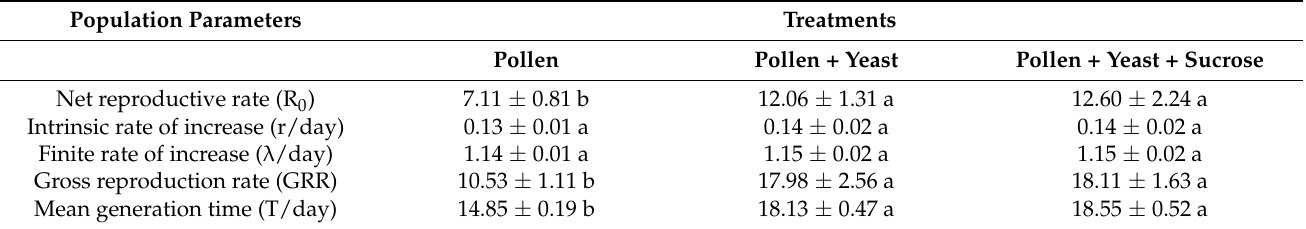
Table 2. The population parameters of Amblyseius orientalis individuals in the different treatment